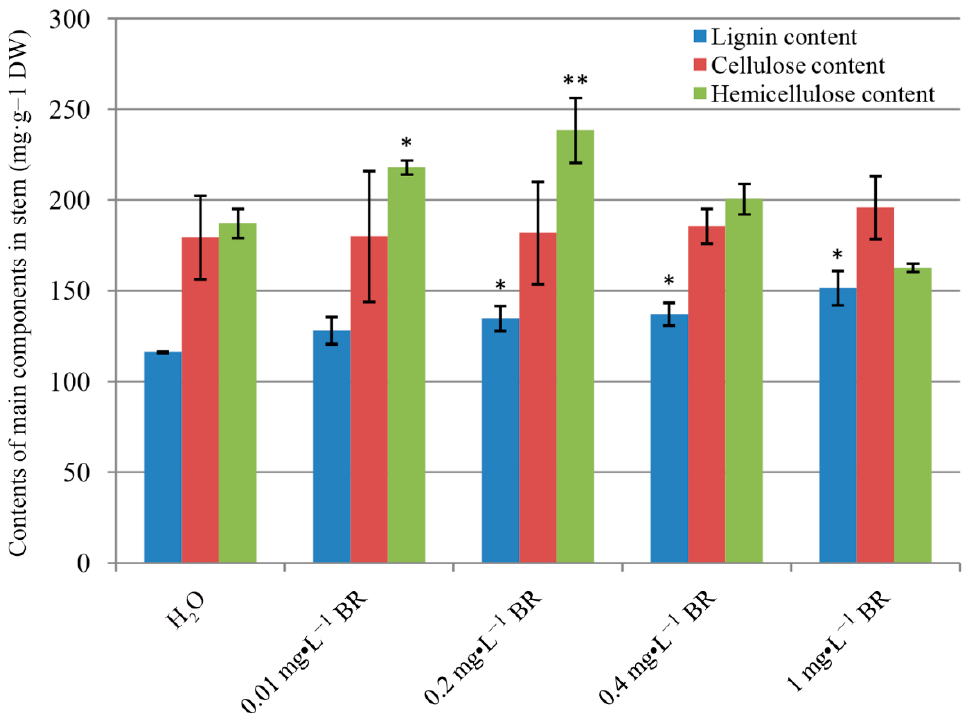
Figure 2. Quantification of the contents of lignin, cellulose and hemicellulose after four-month growth at series of BR treatment. DW means drought weight. Error bars ± SE. * and ** indicate significant differences in comparison with control at p < 0.05 and p < 0.01, respectively.